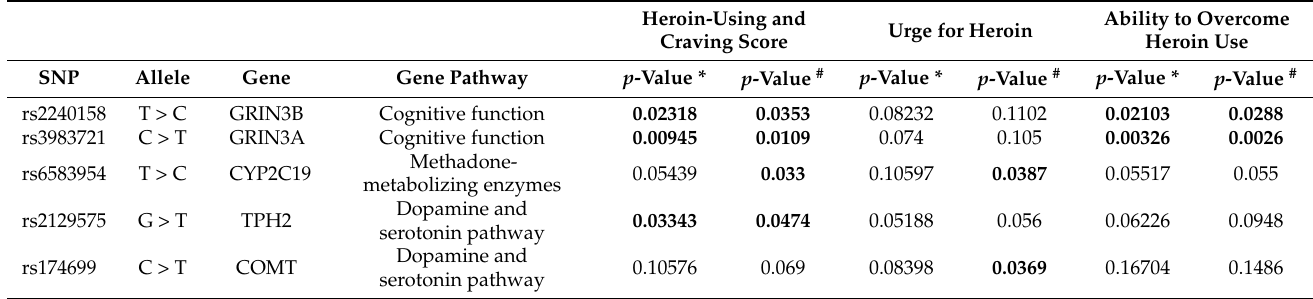
Table 2. Significant associations from single nucleotide polymorphism (SNP) analysis.